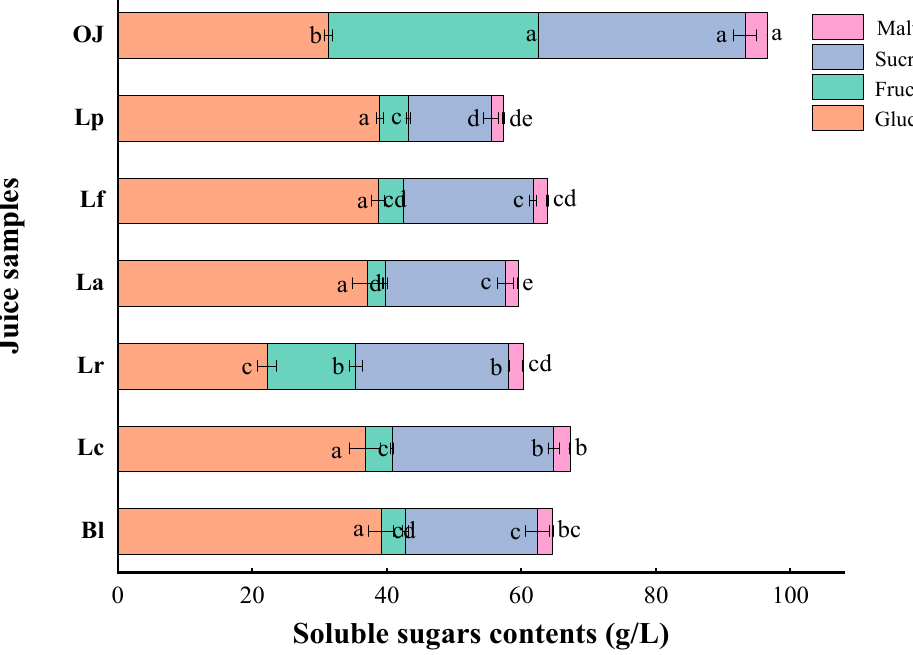
Figure 1. Soluble sugars contents of the orange juices fermented by Lactiplantibacillus plantarum (Lp), L . fermentum (Lf), L . acidophilus (La), L . rhamnosus (Lr), L . paracasei (Lc), Bifidobacterium longum (Bl) and control ( n = 3). Control (OJ) was original orange juice. a–e Different letters in the same column indicate significant differences ( p < 0.05).